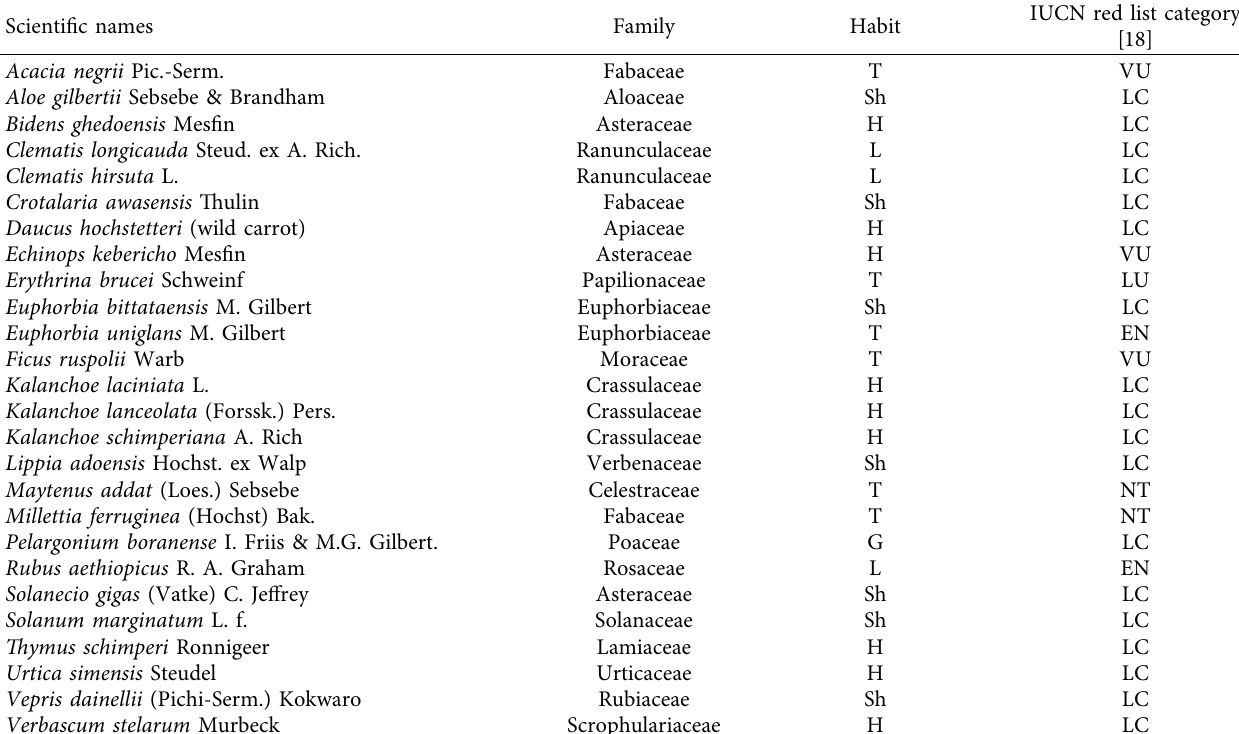
Table 3: List of endemic species of DUBEG, their habit, and IUCN red list